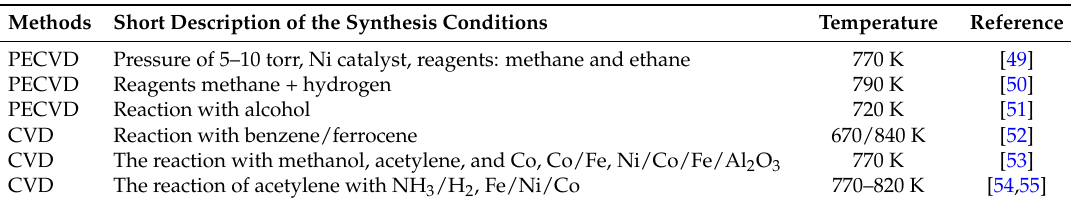
Table 1. Conditions for experimental reactions for the synthesis of carbon nanotubes (literature).